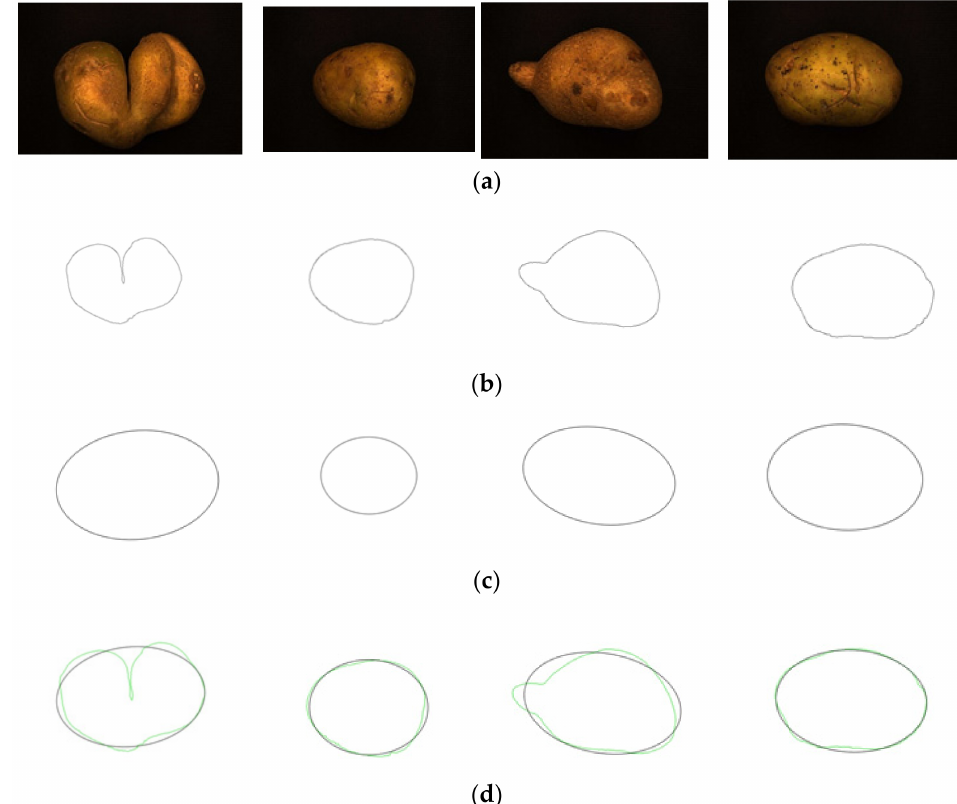
Figure 5. Contour images vs. ellipse images: ( a ) original images, ( b ) contour images, ( c ) ellipse images, and ( d ) overlay of profile images on ellipse